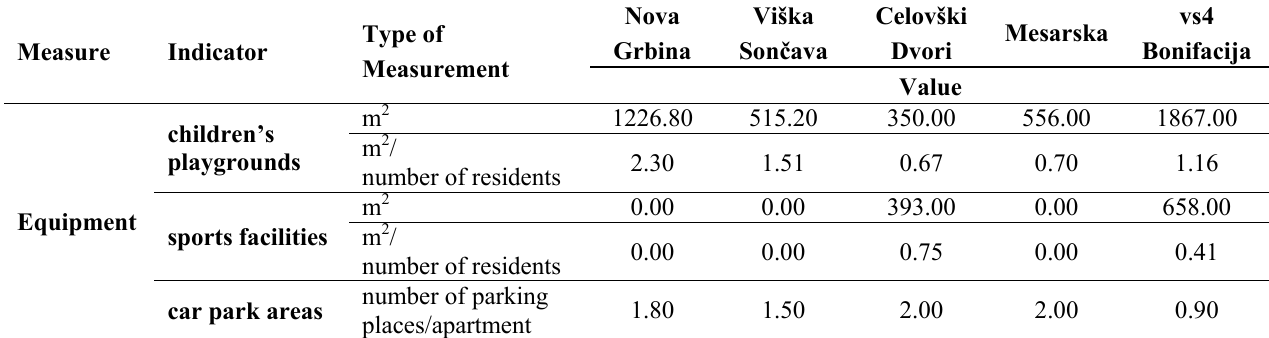
Table 2. Evaluation of residential areas: spatial measure “equipment”, described by different